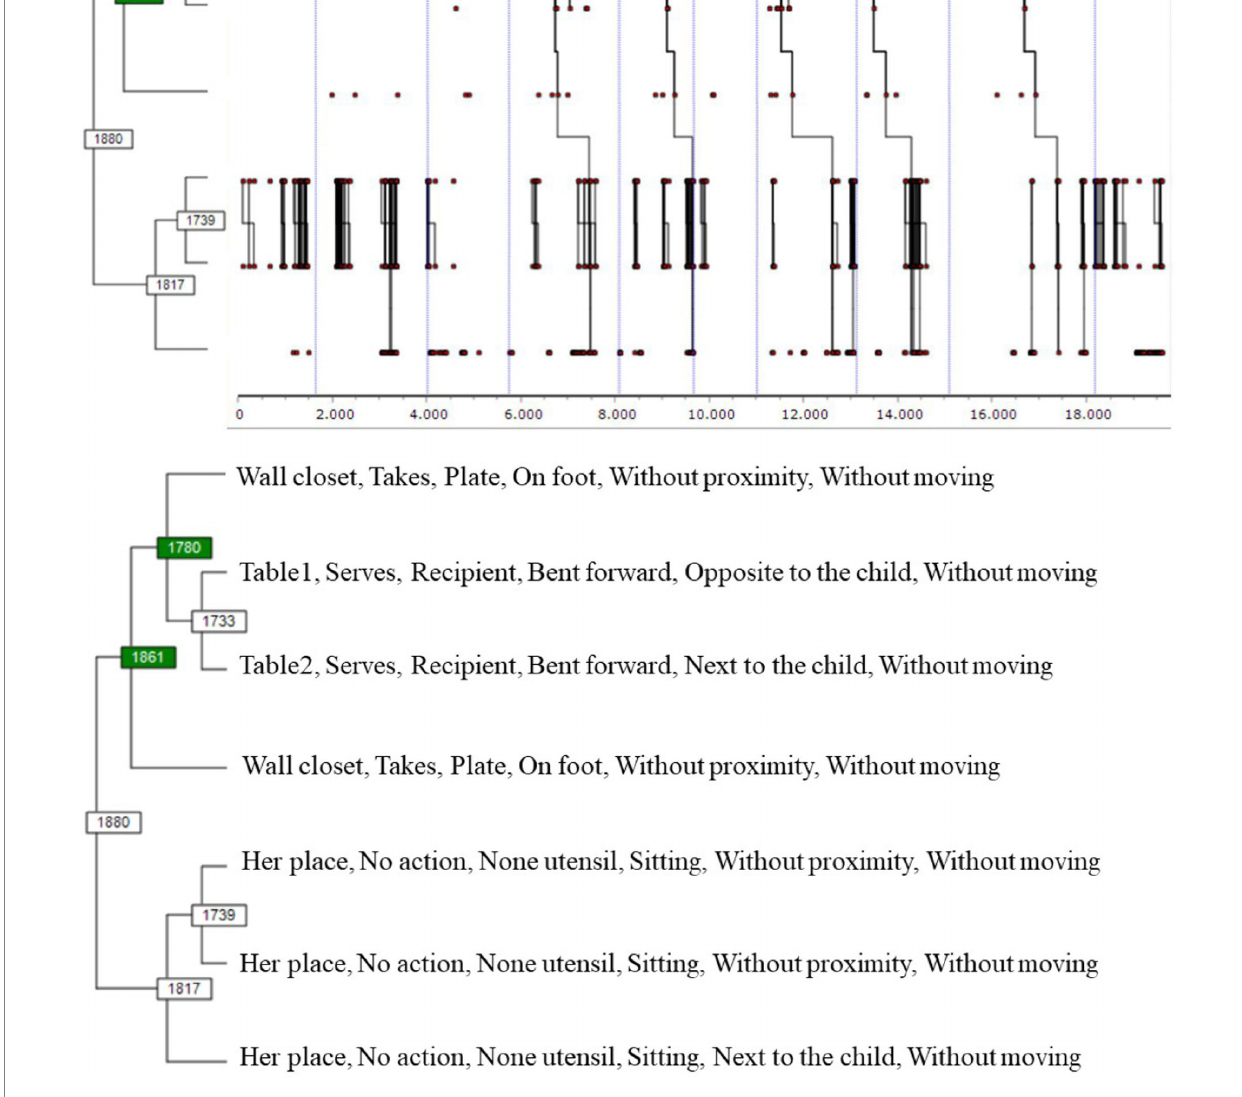
FIGURE 1 T-pattern of Educator-1 ʼ s behavior obtained with